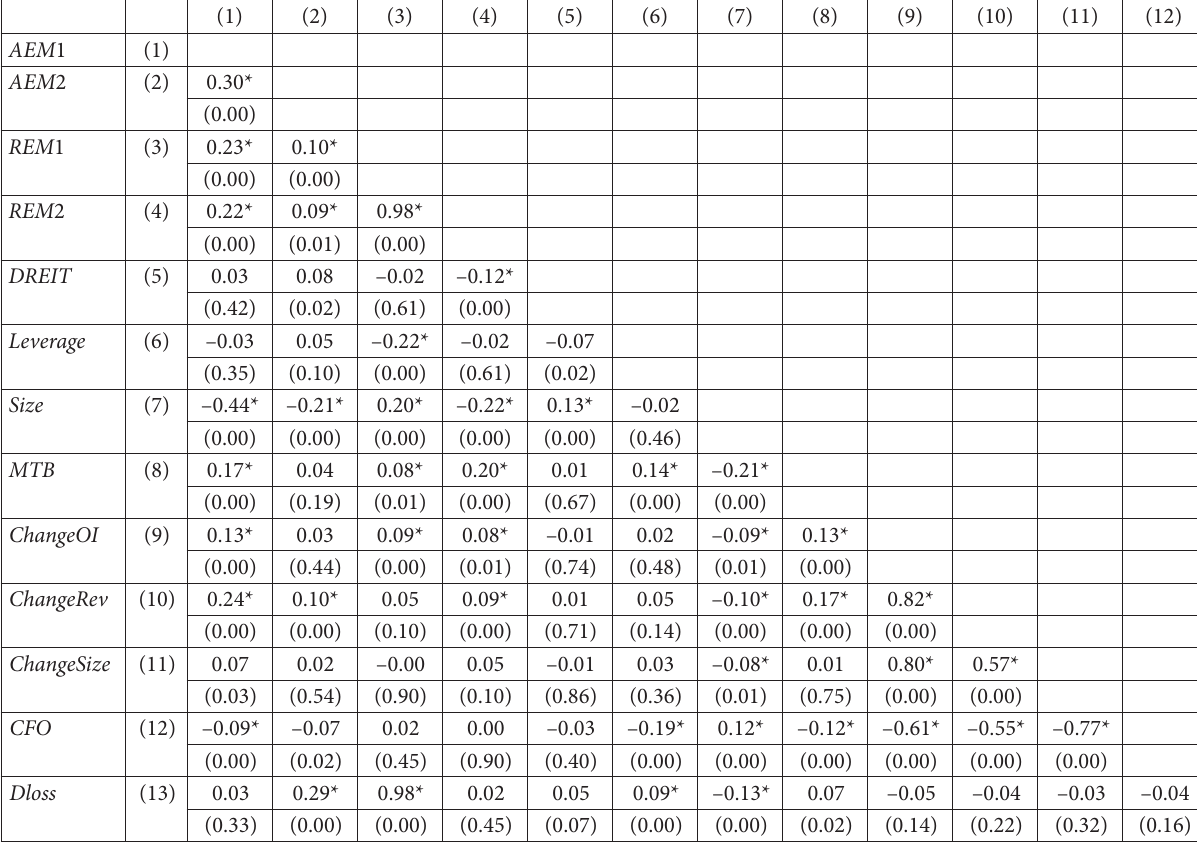
Table 4. Correlation coefficients of independent and dependent